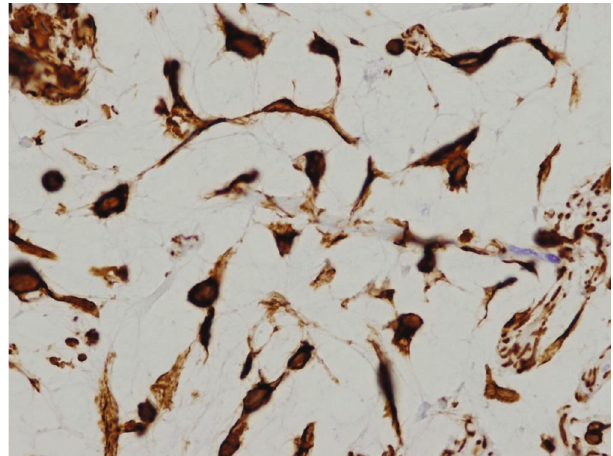
Figure 5: Histopathologic photograph showing the results of immunohistochemical analyses for vimentin, which is positive in the tumor cells (vimentin, ×